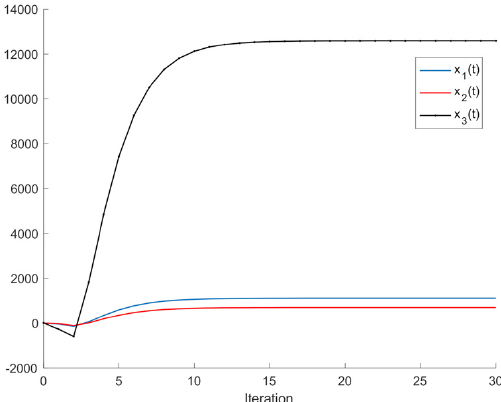
Figure 10. Evolution of the stock vector x t in Example 5 under a dyadic K x = b ˆ k T x control matrix.